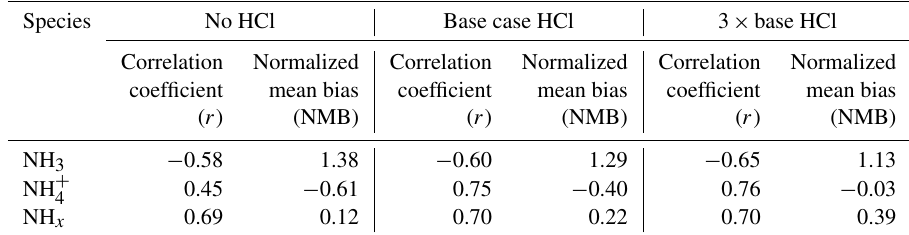
Figure 9. Diurnal variation in the mean (a) NH 3 concentration (b) NH simulated in no HCl (dotted red), base case HCl (dashed red), and 3 × base HCl (solid red) runs. Table 3. Model performance statistics for NH 3 , NH